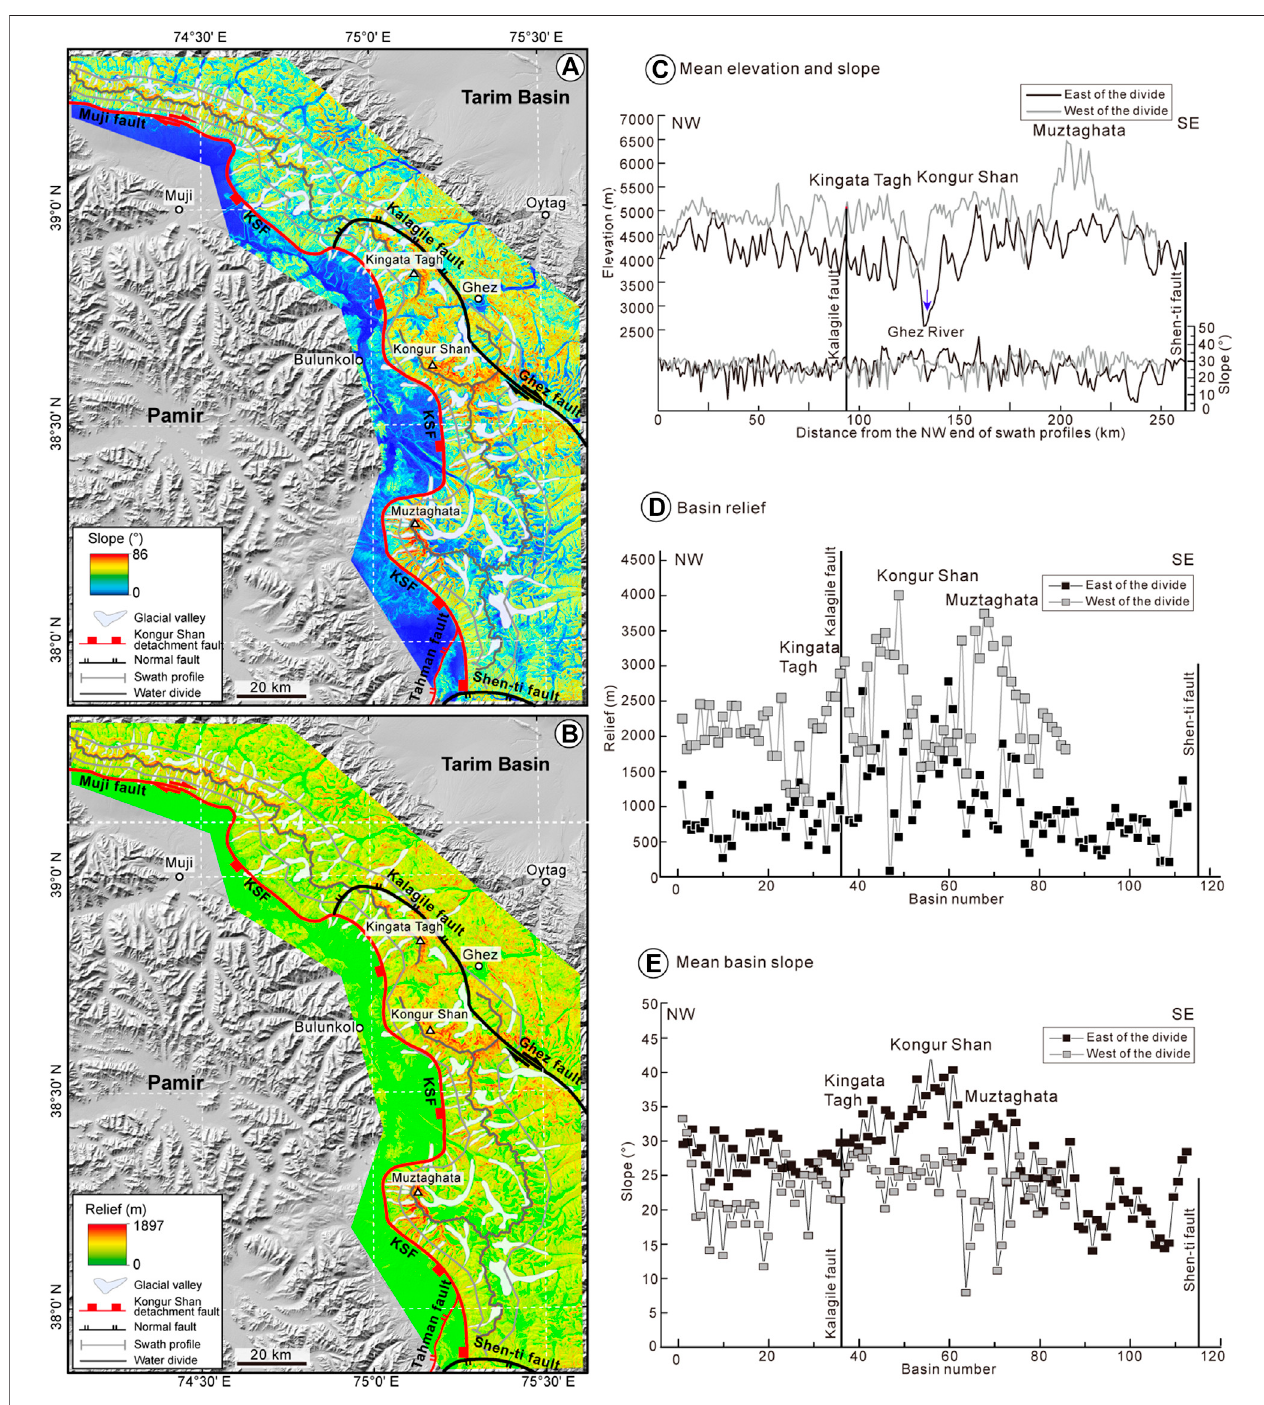
FIGURE5| Spatialdistributionofmorphometricparametersalongwaterdivide.Topographic slope (A) andrelief (B) . (C) Mean elevation and slopeenvelops along two swath pro fi les. Relief (D) and slope (E) of basins on each side of divide.